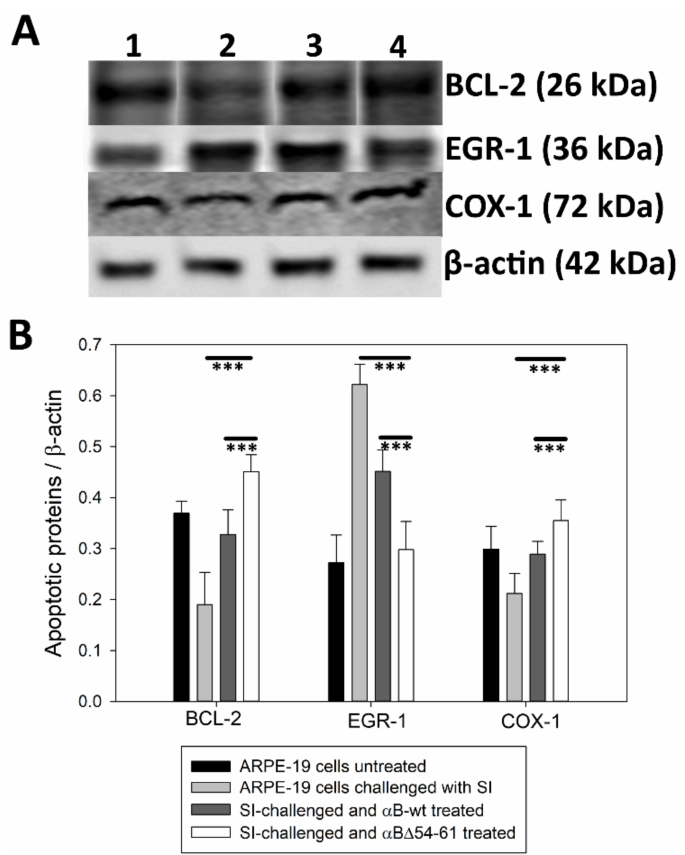
Figure 9. Immunoblot showing the intensity of apoptotic cascade components. ( A ) Western blotting analysis showing the intracellular expression of apoptotic cascade components in experimental groups of ARPE-19 cells. (1) ARPE-19 cells untreated, (2) ARPE-19 cells treated with 7.5 mM SI, (3) ARPE-19 cells simultaneously treated with 7.5 mM SI and 1 µ M of α B-wt, (4) ARPE-19 cells simultaneously treated with 7.5 mM SI and 1 µ M of α B ∆ 54–61. ( B ) Bar graphs of proteins of Bcl- 2, EGR-1, and COX-1 normalized to cellular β -actin protein levels. The asterisks (***) indicate a p -value <